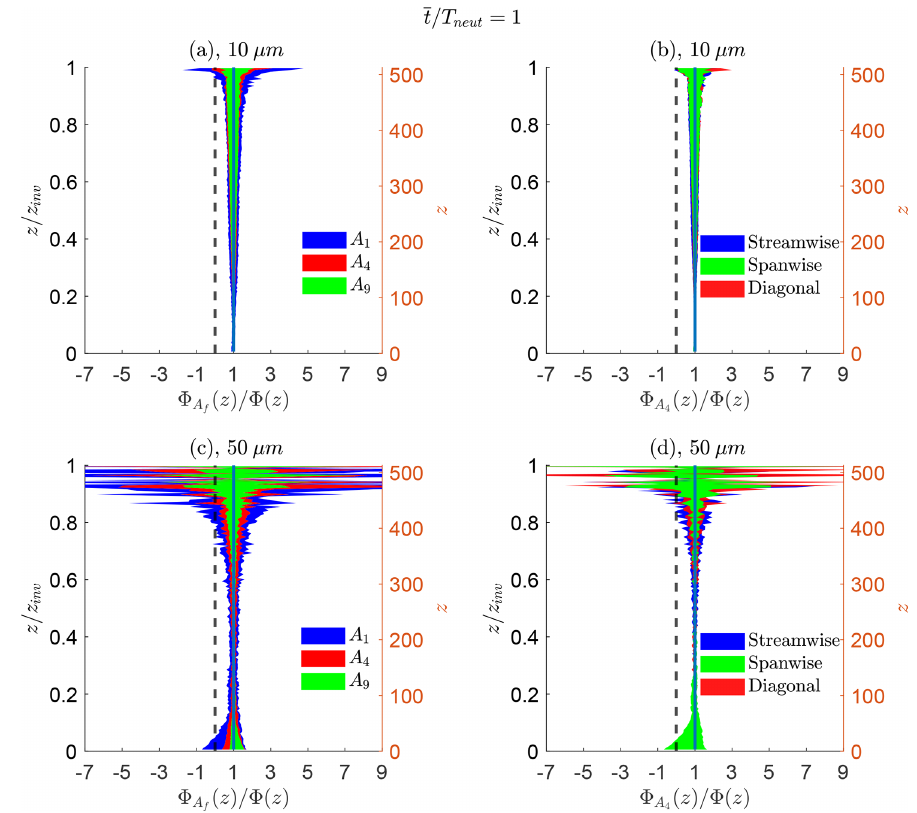
Figure 13. Vertical profiles of predictive flux ranges for 10µm (a, b) and 50µm (c, d) aerosol particle sizes. Panels (a, c) are different subsampling sizes, and panels (b, d) represent directional subsampling given A 4 . The panel layout and configurations are identical to Fig.